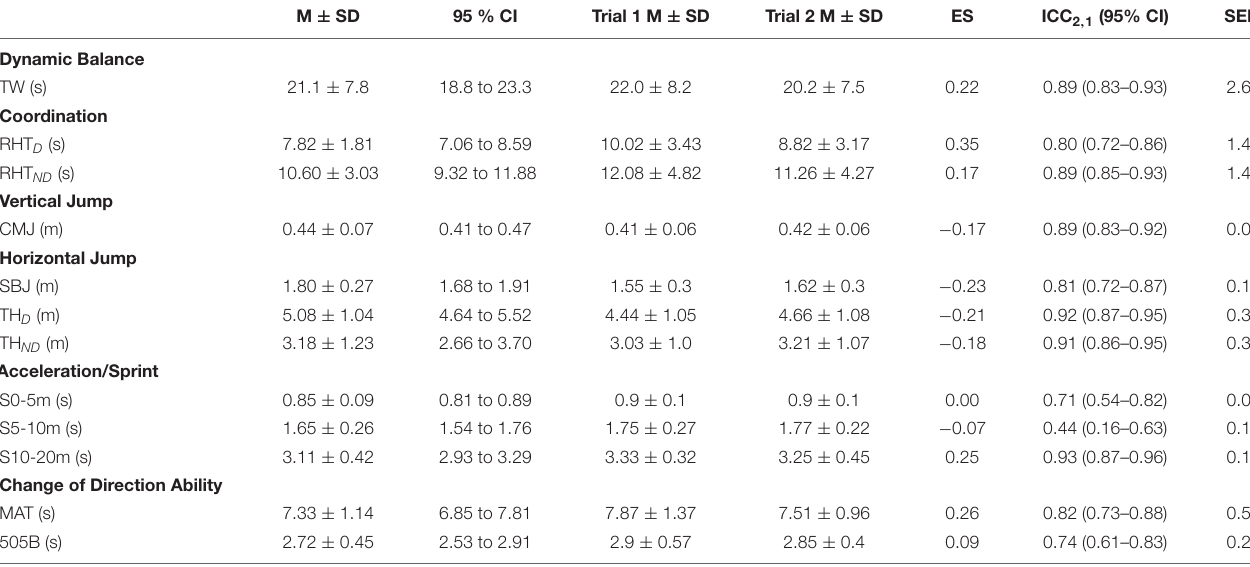
TABLE 2 | Descriptive activity limitation test results (mean ± standard deviation), comparison for each trial and intra-class correlation by all